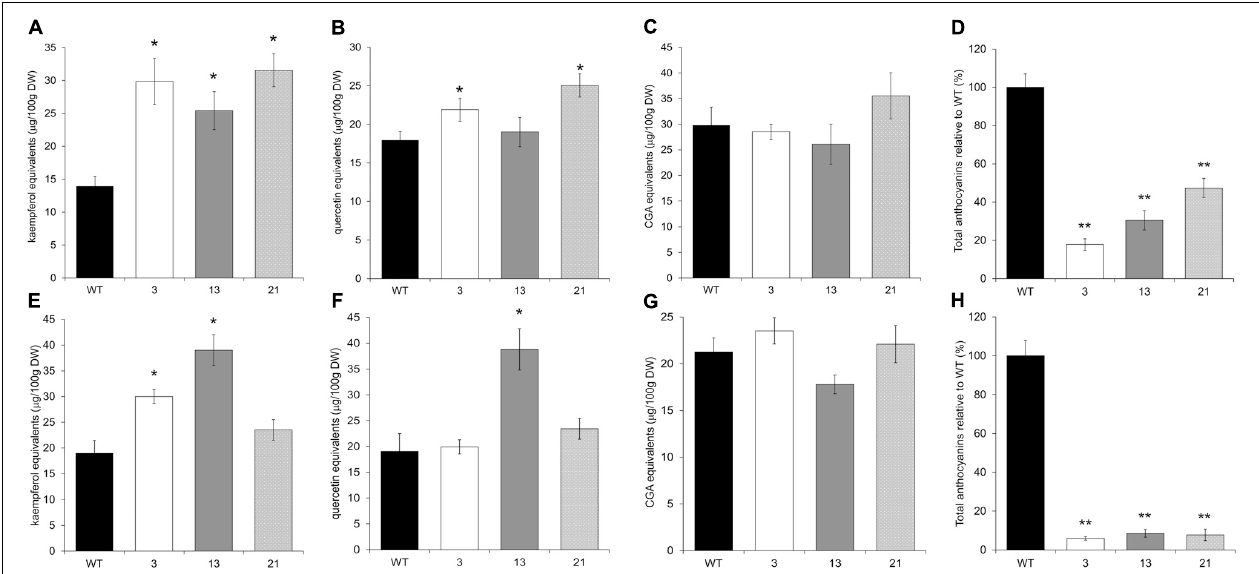
FIGURE 8 | HPLC analyses of flavonoids and caffeoyl-quinic acids in leaves and flowers of tobacco plants overexpressing CcMYB12 protein. Leaves (A–D) and flowers (E–H) from WT and T3 transgenic tobacco lines 3, 13, and 21 were tested. Total kaempferols (A,E) , total quercetins (B,F) , chlorogenic acid (CGA; C) , total caffeoyl-quinic acids (CQAs; G), total anthocyanins (D,H) . Total anthocyanin content is relative (in percentage) to the mean levels of the WT line. Error bars indicate the SD of the average of kaempferol, quercetin, CGA or cyanidin equivalents, and CGA determined as triplicates in three independent biological replicates. Asterisks indicate a statistical difference ( ∗ p -value < 0.05; ∗∗ p -value < 0.01) between the means for WT and for tested transgenic samples, according to Student’s t -test. DW, dry